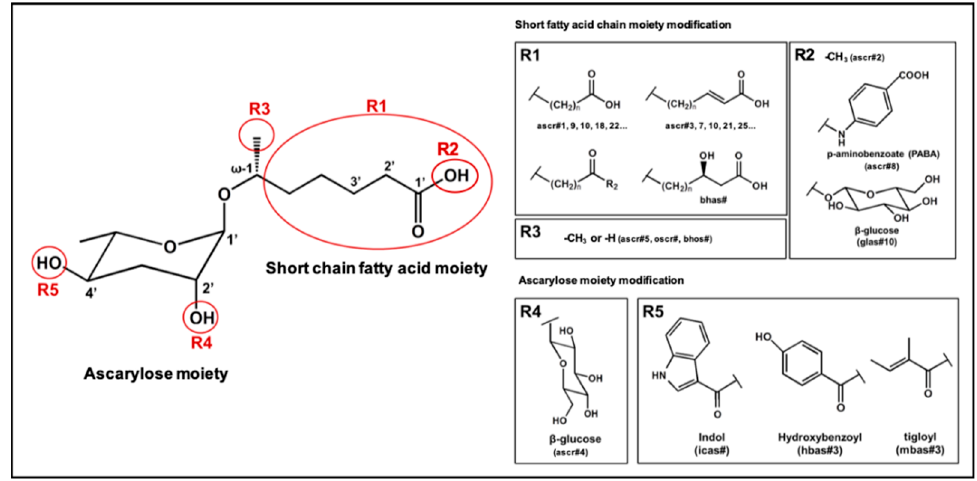
Figure 2. Structural diversity among the known ascr pheromones. Several ascr pheromone analogs modified at various positions (red circles labeled R1–5) have been identified [13,16,17,22–27].